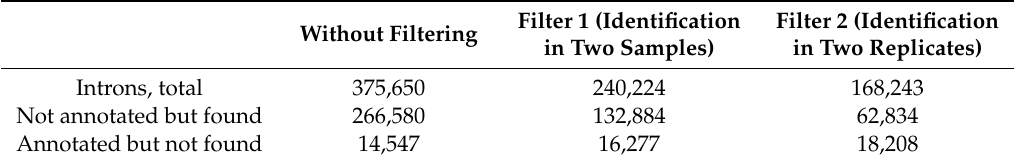
Table 1. Analysis of splicing sites based on newly obtained